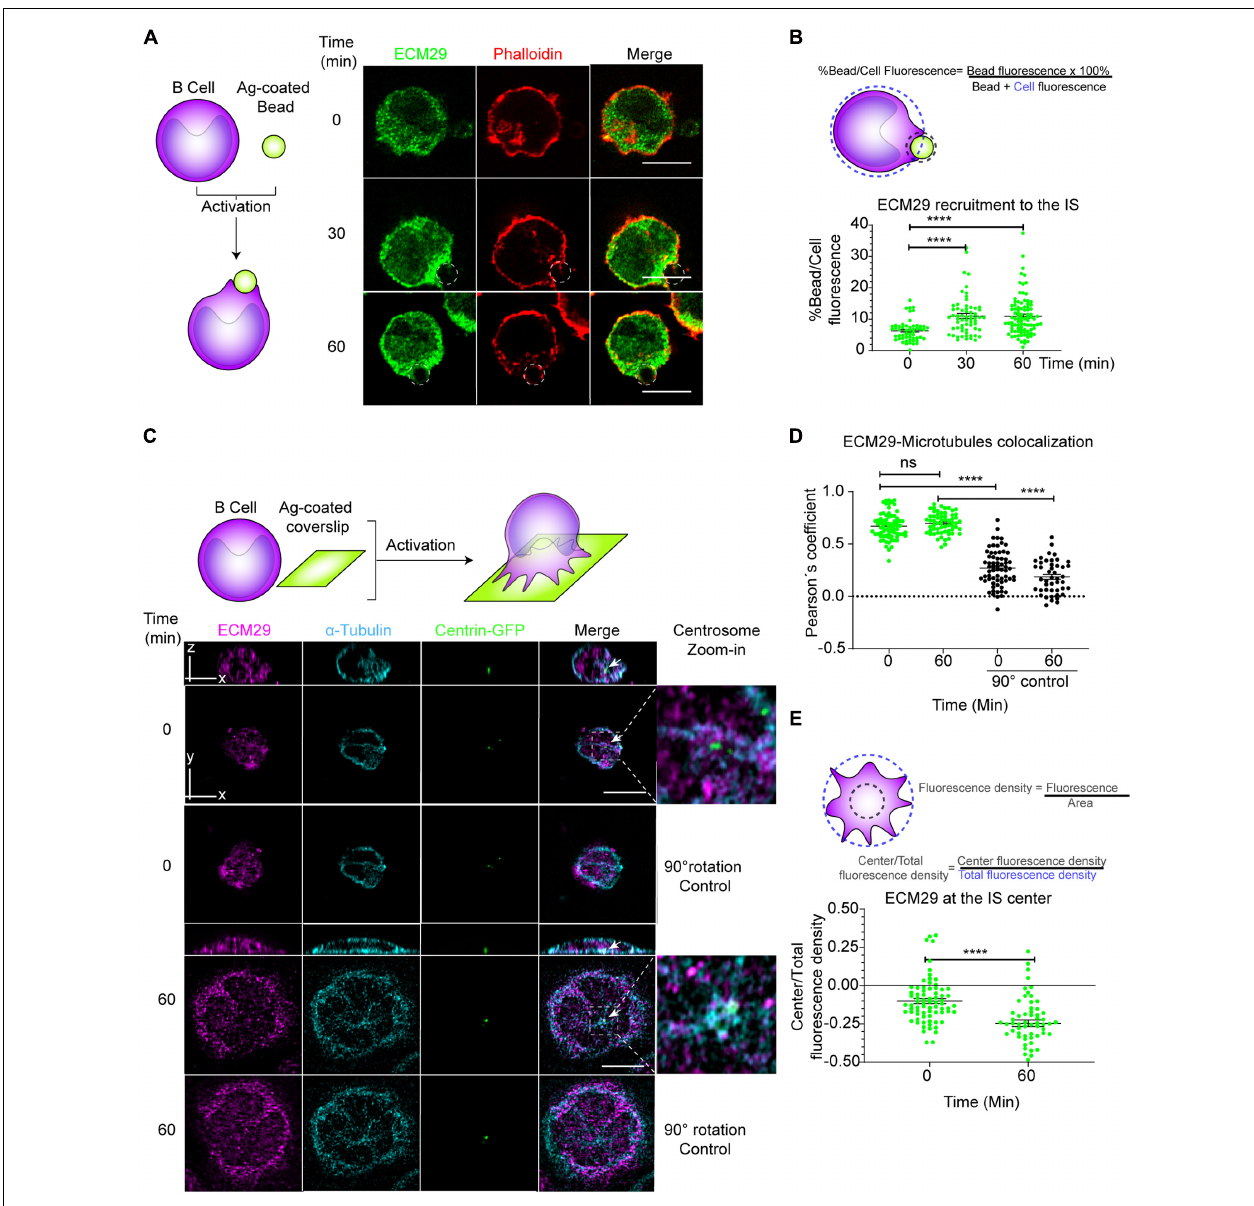
FIGURE 1 | Ecm29 co-localizes with microtubules and the centrosome and is recruited to the IS of B cells: (A) Scheme depicting activation of B cells with antigen-coated beads and representative Airyscan images of B cells activated for different time points (0, 30, and 60 min), labeled for actin (phalloidin) and Ecm29. Dashed white circles represent the bead. (B) Quantification scheme and quantification of Ecm29 recruitment at the immune synapse (Bead) after different time points of activation. N = 4. Cells > 54. (C) Scheme depicting activation of B cells onto antigen-coated coverslips. Representative Airyscan images of centrin-GFP expressing B cells in resting (0 min) and activating (60 min) conditions, labeled for Ecm29 (magenta), microtubules ( α -tubulin, cyan). White arrows indicate the centrosome. Magnifications of centrosome areas (9 µ m 2 ) are shown. 90 ◦ channel rotation control is shown for both time points (Means: 0,27 and 0,18 for 0 and 60 min of activation, respectively). (D,E) Quantification of the colocalization of Ecm29 with microtubules and its accumulation at the IS center (see scheme) from experiment shown in C. N = 2. Cells > 61. **** p < 0.0001. Kruskal–Wallis test with Dunn’s test, and Mann–Whitney test was performed for all statistical analyses. Mean with SEM bars are shown. Scale bar = 10 µ m. ns,